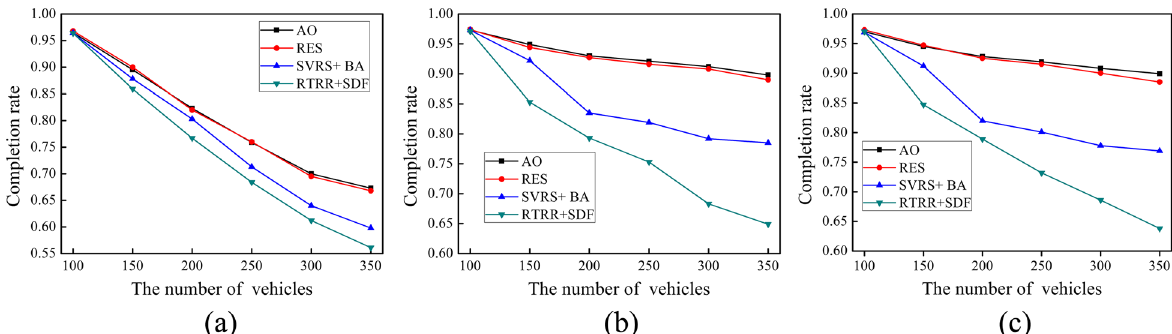
Fig. 5 Impact of completion rate. a I i = unif ( 100,1000 ) kbps , ξ i = unif ( 500,1000 ) ms b I i = unif ( 100,500 ) kbps , ξ i = unif ( 500,1000 ) ms c I i = unif ( 100,1000 ) kbps , ξ i = unif ( 500,1500 )